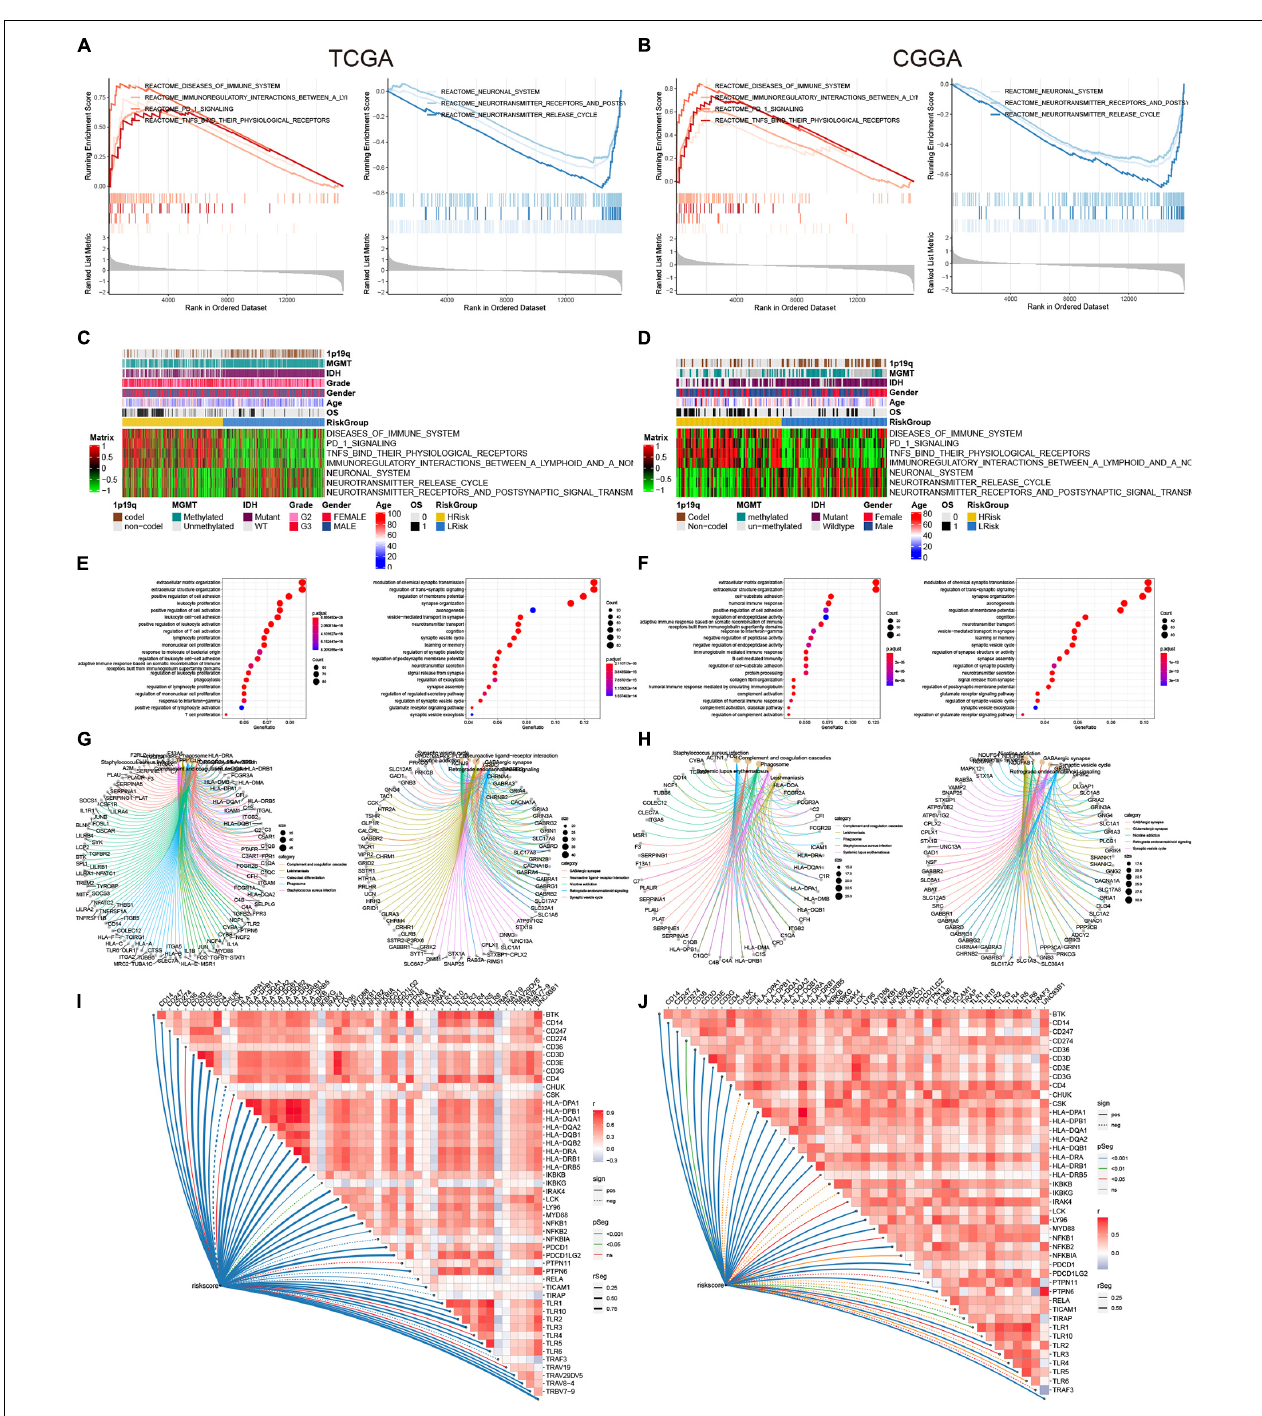
FIGURE 6 | GSEA, GO, and KEGG analysis. (A,B) Regulatory pathways of the enrichment analysis in the high-and low-risk groups. (C,D) The heat maps of the scores of enrichment pathways in each sample. (E,F) GO analysis. (G,H) KEGG analysis. (I,J) The association between the risk score and some immune-related